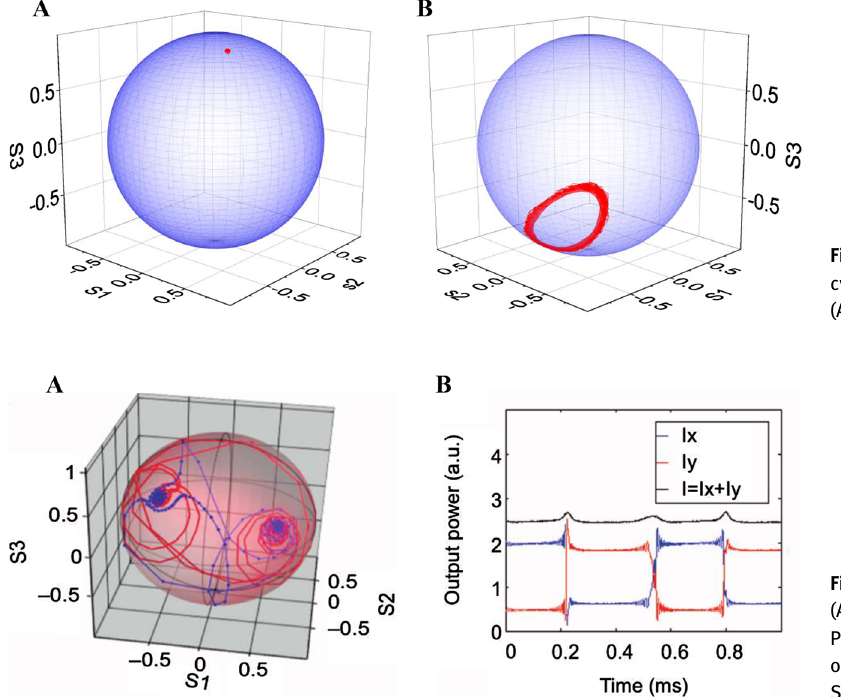
Figure 11: Results of double spiral attractors. (A) Polarization trajectory shown on Poincare sphere. (B) Power of two orthogonal polarization component. Sergeyev et al. [295]. © CIOMP